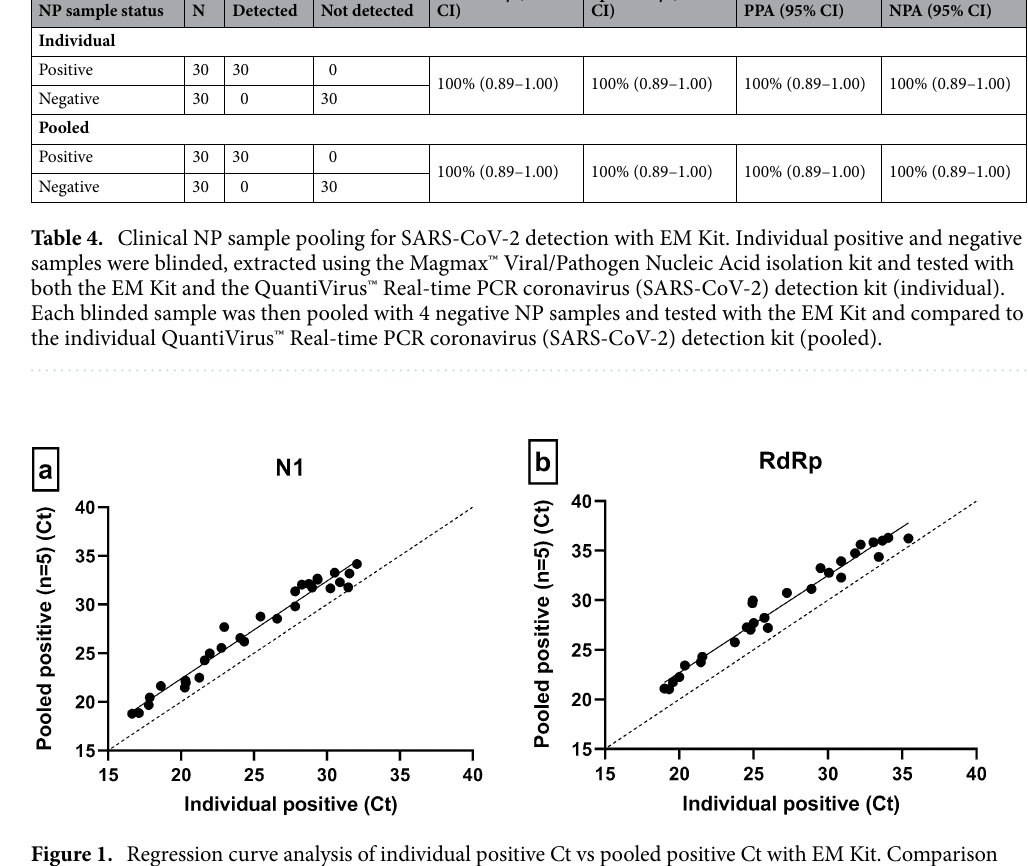
Figure 1. Regression curve analysis of individual positive Ct vs pooled positive Ct with EM Kit. Comparison of individual sample Ct ( x ) versus pooled sample Ct ( y ) for 30 SARS-CoV-2 positive NP swab samples. ( a ) N1 Ct comparison: + 2.4 Ct, 95% CI = 0.48–4.16, R 2 = 0.97. ( b ) RdRp Ct comparison: + 2.6 Ct, 95% CI = 1.05–5.18, R 2 =